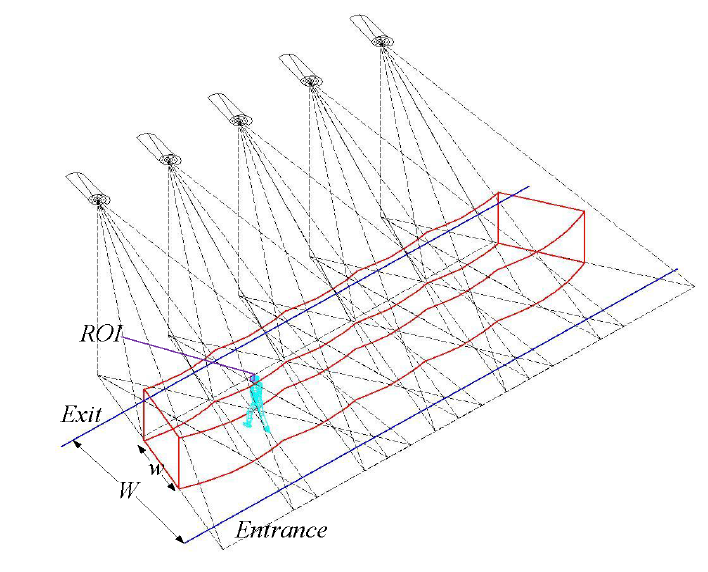
Figure 4. Barrier coverage using the 3D sensing